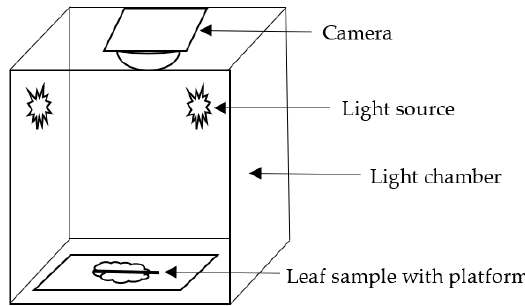
Figure 3. Schematic diagram of the image acquisition system.